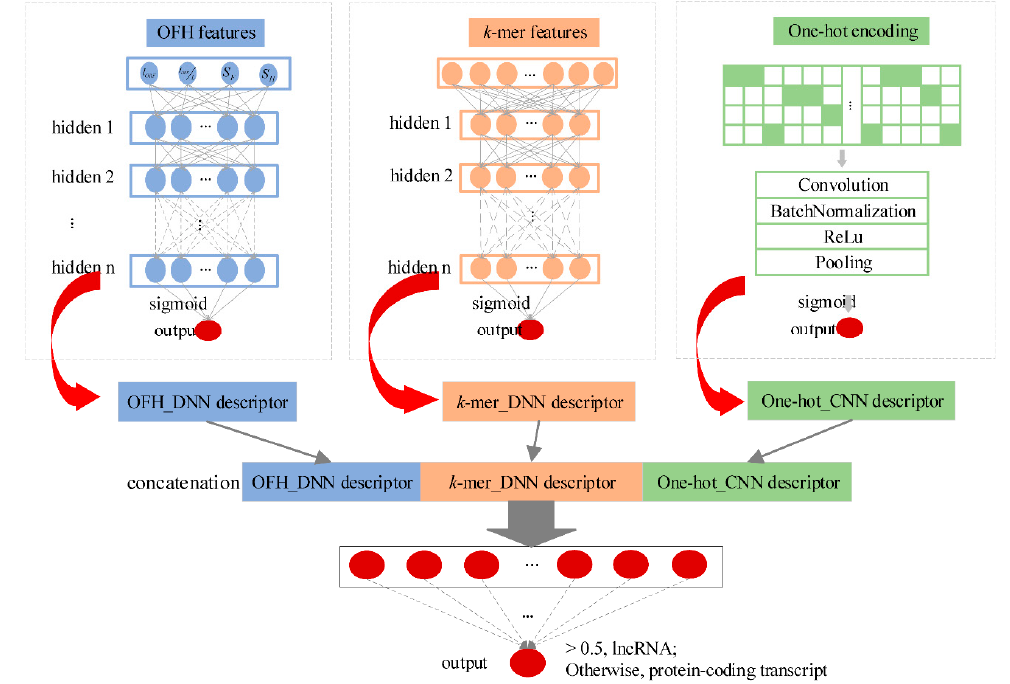
Figure 1. Overview of the lncRNA_Mdeep.